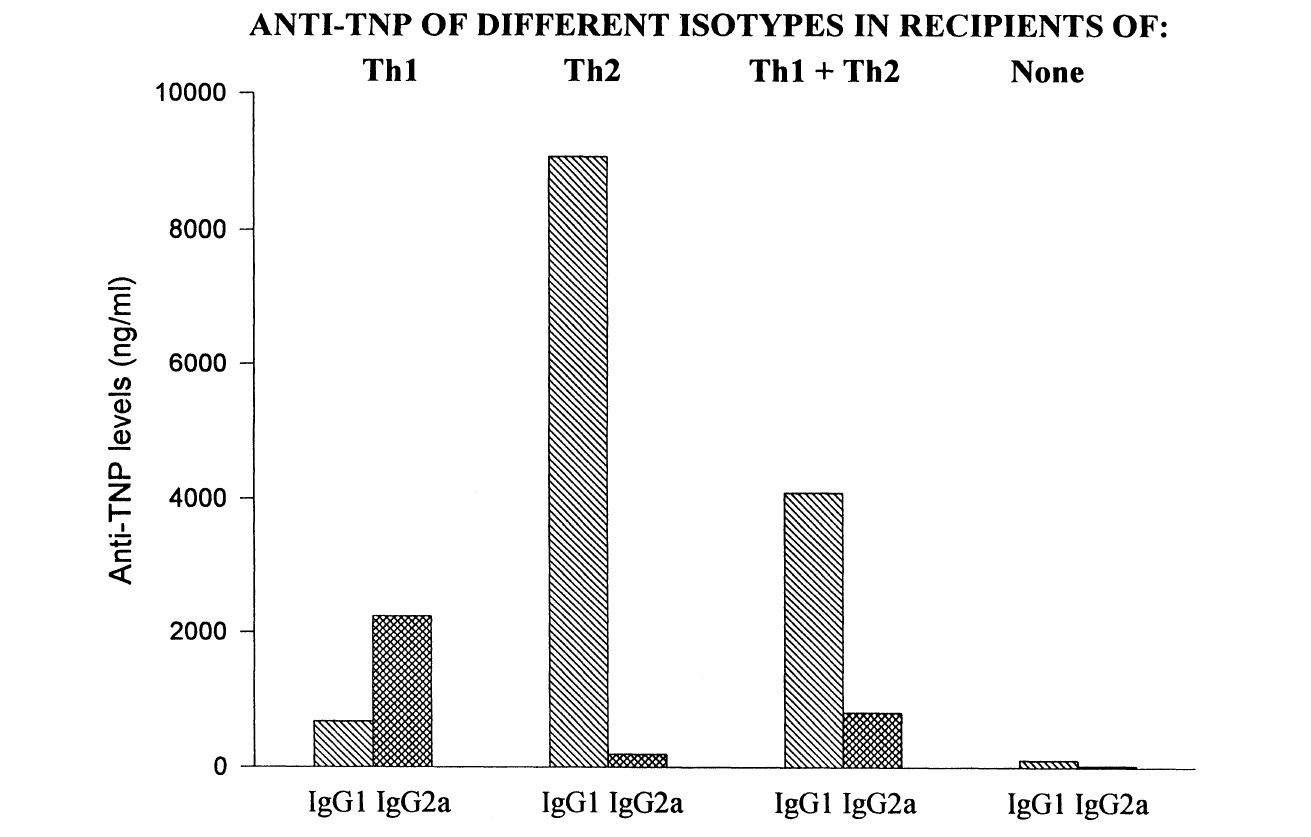
FIGURE 3 Effect of KLH-specific Thl and Th2 clones on antibody formation to TNP-KLH in nu/nu BALB/c mice. The same mice as shown in Fig. 2 were bled on day 15 and their sera were analyzed by ELISA for anti-TNP of various isotypes. Data are adapted from Secord et al.,